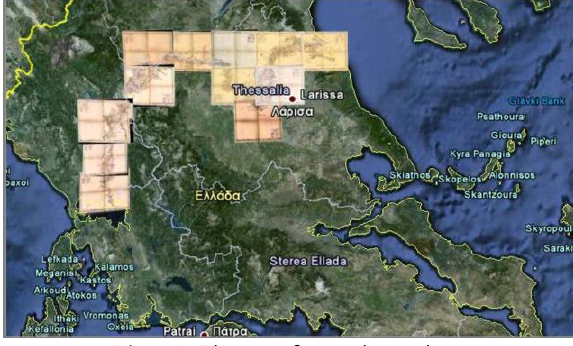
Figure 2. The georeferenced map sheets